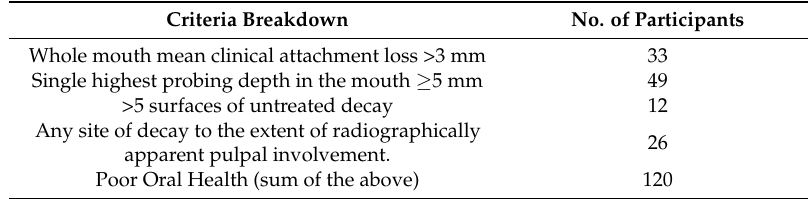
Table 2. Criteria breakdown in the poor oral health group based on oral exam (N).